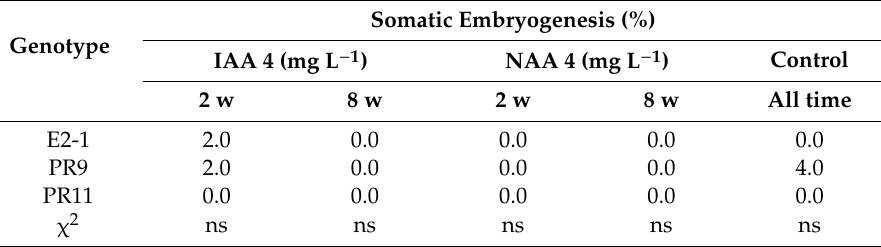
Table 7. E ff ect of genotype and auxin treatment on embryogenic response in shoot apex explants derived from axillary shoot cultures of three tolerant Quercus ilex genotypes. Somatic Embryogenesis Genotype